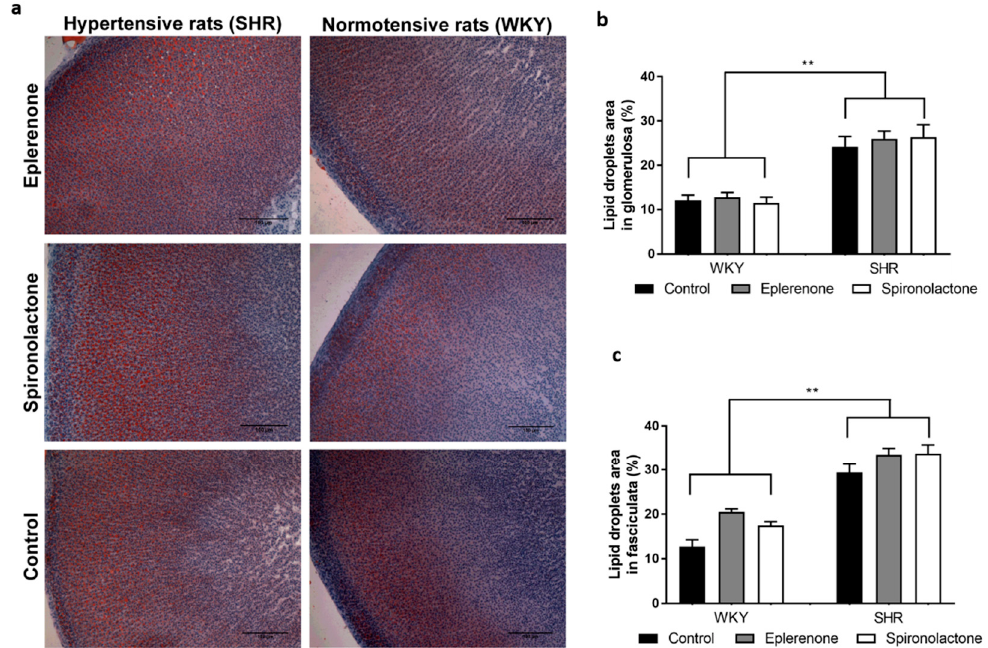
Figure 2. Adrenal glands stained with oil red O (100×) ( a ) and the area of the glomerulosa ( b ) and fasciculata ( c ) layers occupied by lipid droplets. ** p < 0.01.